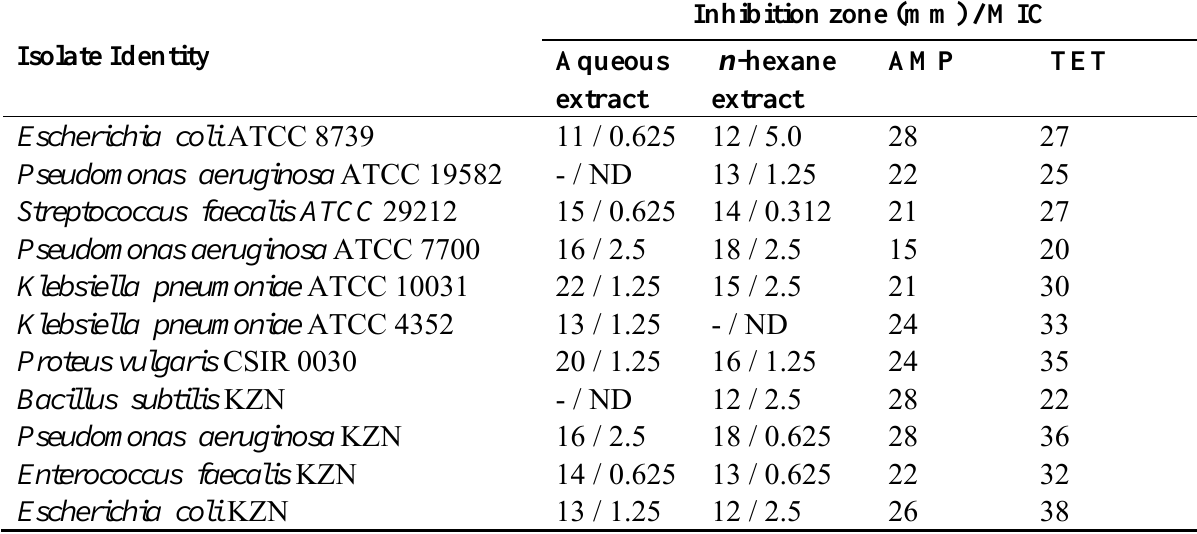
Table 1. Antibacterial activities of crude aqueous and n -hexane extracts of C . nucifera